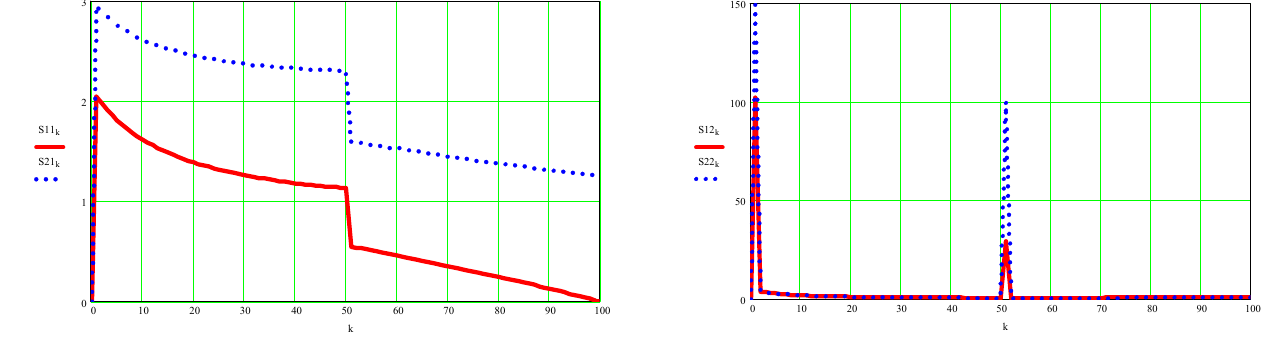
Figure A8. On the left are the absolute velocities of the center of mass of element 1 (red) and that of element 2 (blue); on the right the graphs of the absolute accelerations of the same points S1 and S2 respectively. (6) Inverse kinematics in a 2R robot plane (6) Kinematics (forces and motor moments in the mechanism are determined)